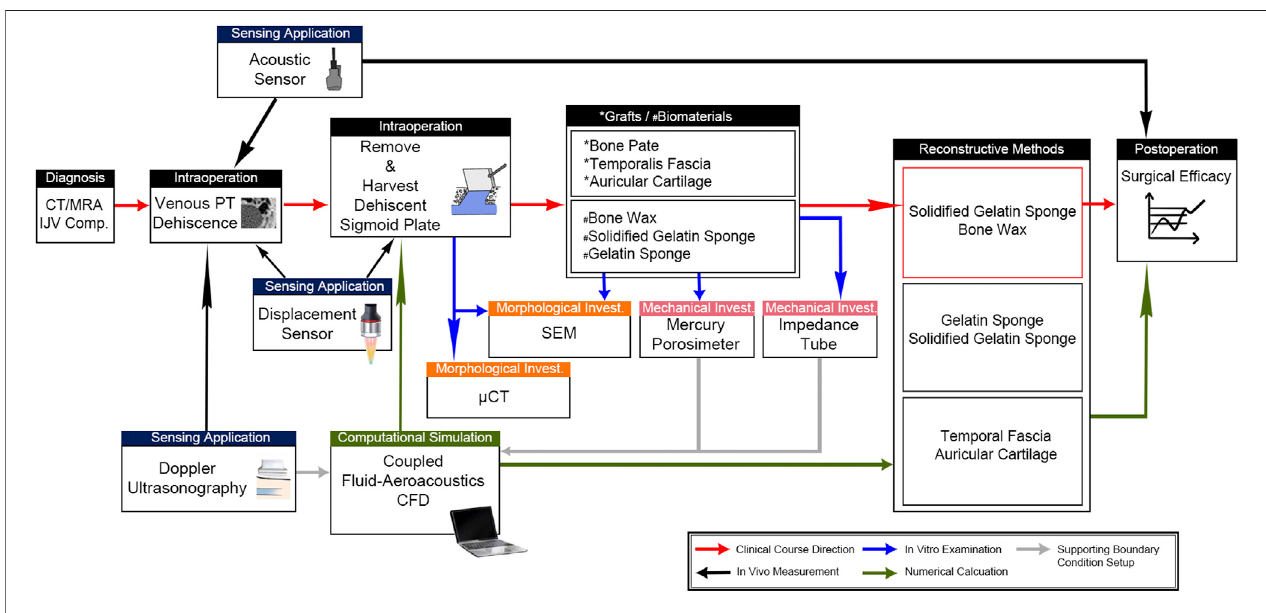
FIGURE 1 | Complete work fl ow to determine the source of PT and therapeutic ef fi cacy of graft/biomaterial applications. Intraoperative sensing applications were deployed to differentiate the intrasinus fl ow-borne and/or solid-borne vibration characteristics. Afterward, the morphological and mechanical properties of harvested dehiscent sigmoid plate and cadaveric grafts/external biomaterials were studied using μ CT, SEM, mercury porosimetry, and impedance tubes. These mechanical properties were acquired to support the coupled fl uid-aeroacoustics CFD simulation for the quanti fi cation of the surgical ef fi cacy of the three reconstructive techniques. CFD data were also veri fi ed by the acoustic sensing results to justify the aeroacoustics amplitude of